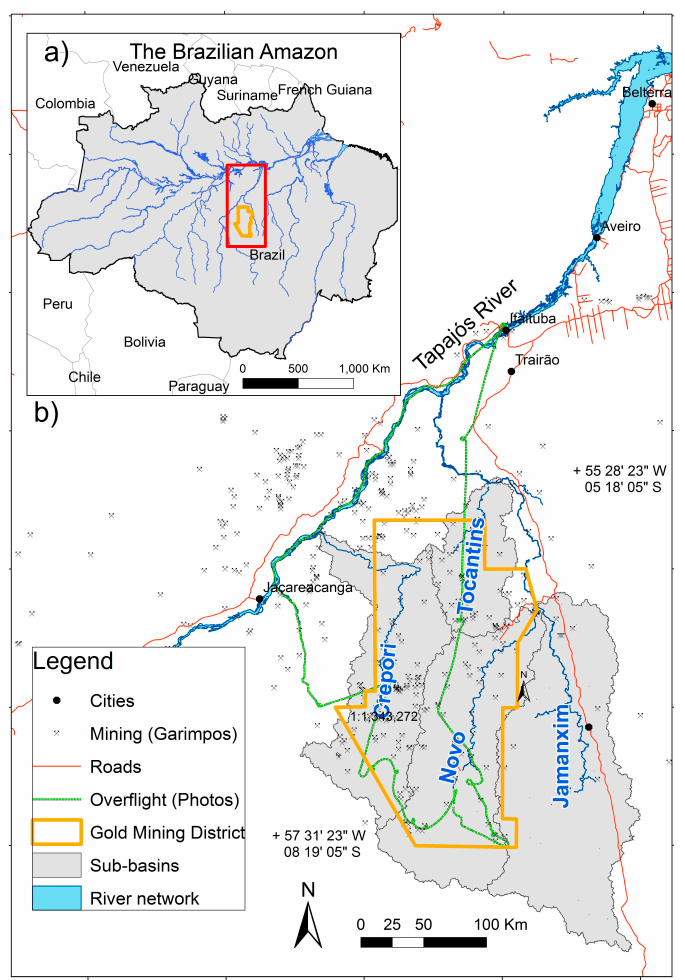
Figure 1. ( a ) Study area located in the Brazilian Amazon with indication of the Gold Mining District created in 1983 [6] by the Brazilian Federal Government. The four sub-basins of the Tapajós River Basin subject to this research are within: Jamanxim, Novo, Tocantins and Crepori sub-basins are depicted in ( b ), along with mining sites, roads, river network, and overflight path for aerial photos used in the land-cover validation